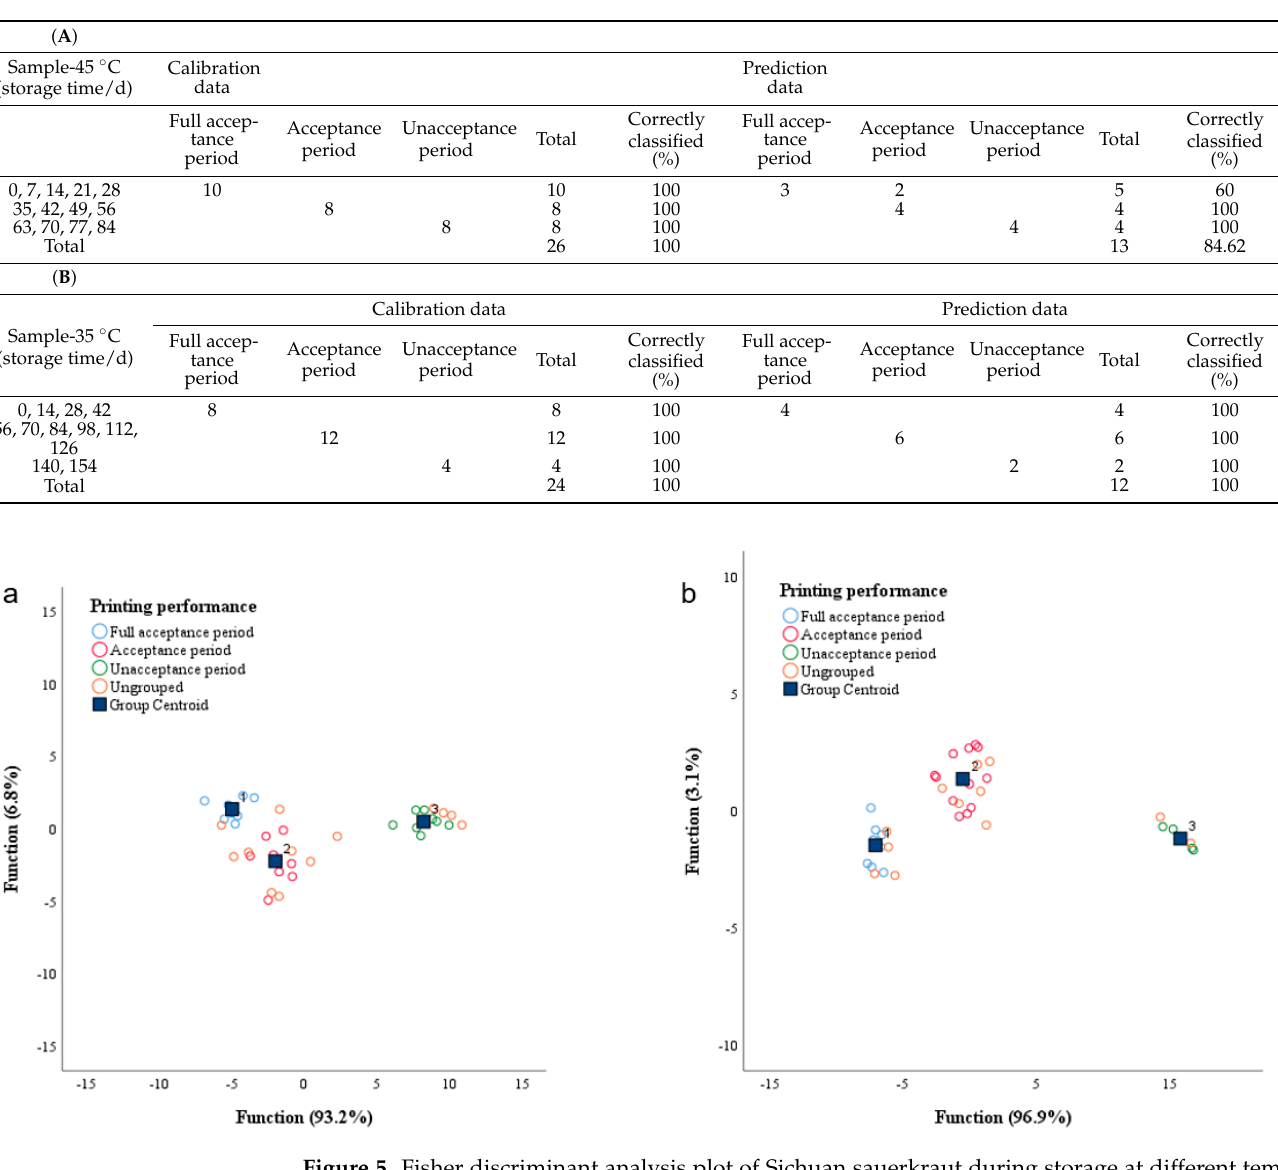
Table 5. ( A ) Fisher discriminant analysis was used to classify Sichuan sauerkraut during storage at 45 °C. ( B ) Fisher discriminant analysis was used to classify Sichuan sauerkraut during storage at 35 °C.